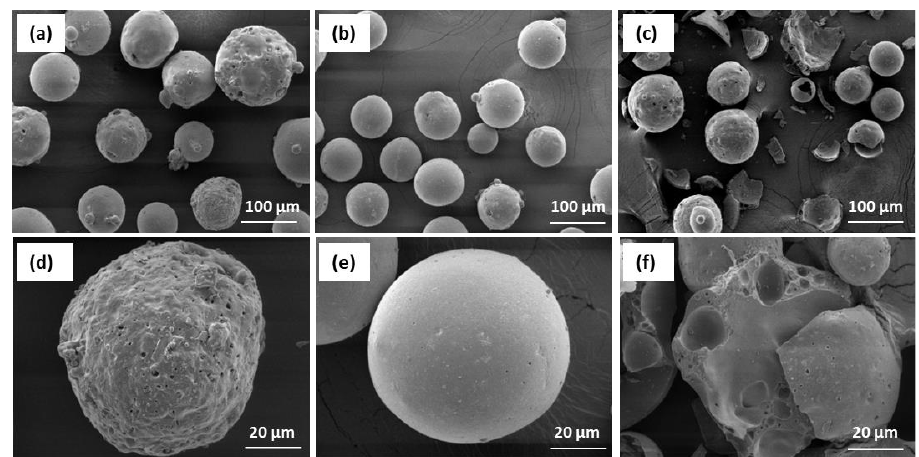
Figure 6. SEM micrographs of the cenospheres: CS1 ( a ) and ( d ); CS2 ( b ) and ( e ); CS3 ( c ) and ( f ).